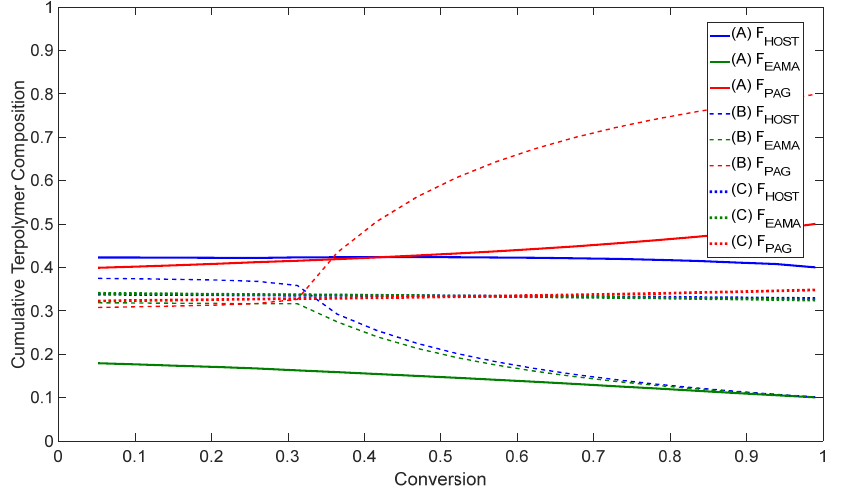
Figure 3. HOST / EAMA / PAG terpolymer composition prediction for f 1,0 / f 2,0 / f 3,0 = 0.1 / 0.1 / 0.8.